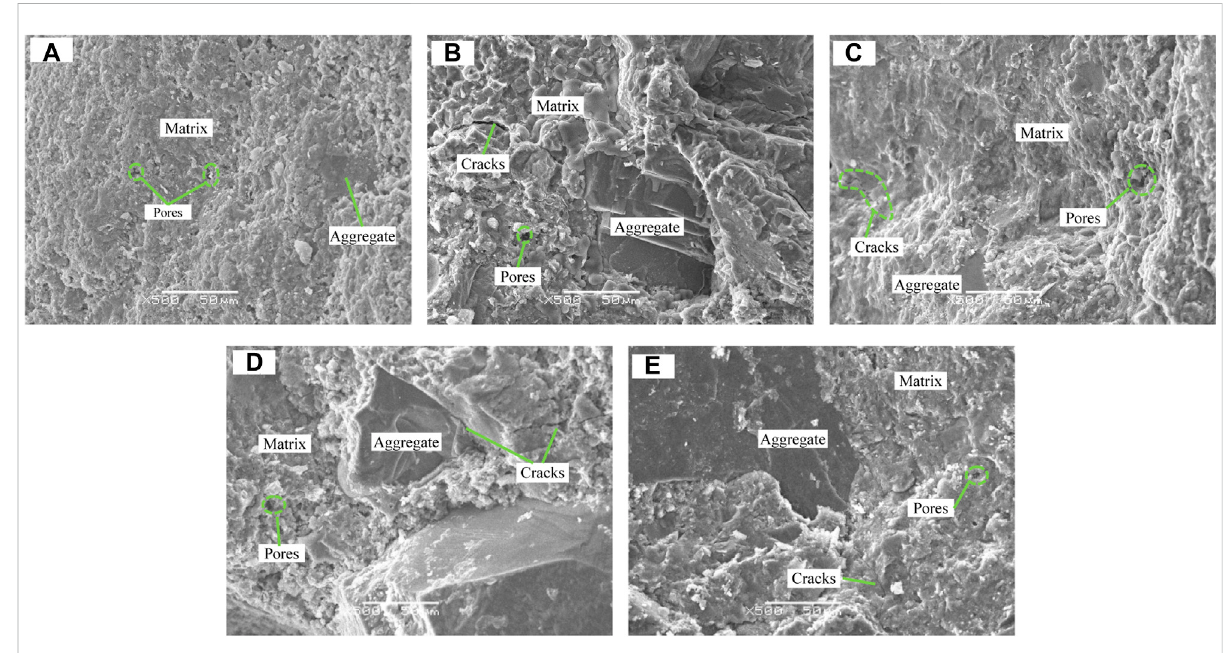
FIGURE 12 Microstructure of aggregate and matrix of concrete; (A) GS0; (B) GSa; (C) GSb; (D) GSc; (E) GSd.